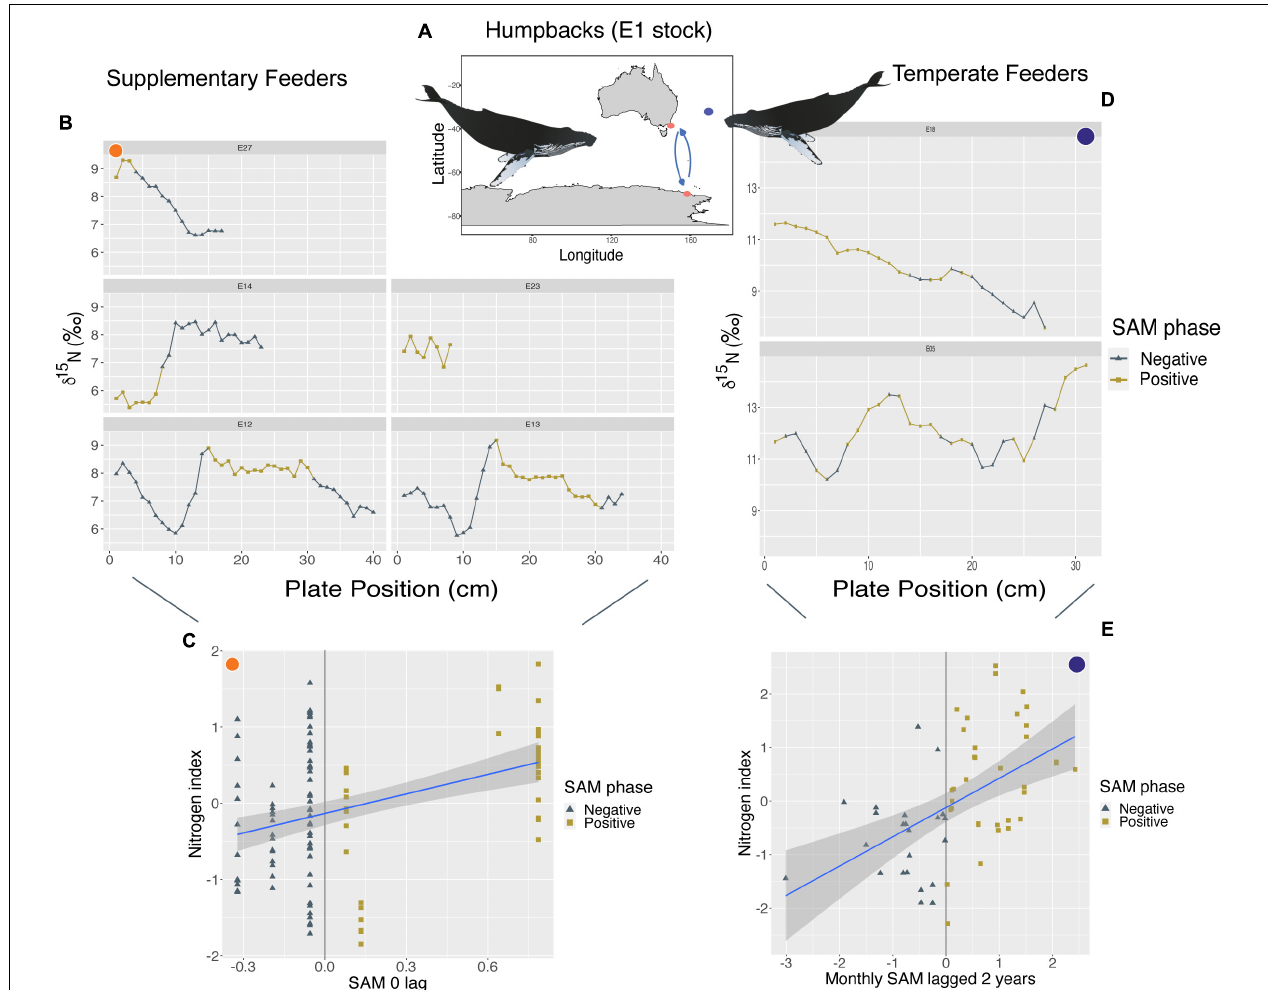
FIGURE 2 | (A) Orange circles represent the approximate feeding locations of humpbacks from the E1 breeding stock (Southwest Pacific Ocean) that supplement their feeding in Australian waters ( n = 5, sample points = 122). Purple circle represents an approximate location of humpbacks from the same breeding stock that remain in Australian waters year-round (known as temperate feeders, n = 2, sample points = 58). (C,E) Show a positive linear relationship between their nitrogen index and SAM, however, supplementary feeders (C) at a 0-year lag ( p < 0.01; R 2 m = 0.16), and temperate feeders (E) at a monthly 2-year lag ( p < 0.01; R 2 m = 0.25). (B,D) Show where these changes in SAM phases occur along baleen and resulting stable isotope patterns of δ 15 N of each individual. Whale image attribution: Tracey Saxby, Integration and Application Network